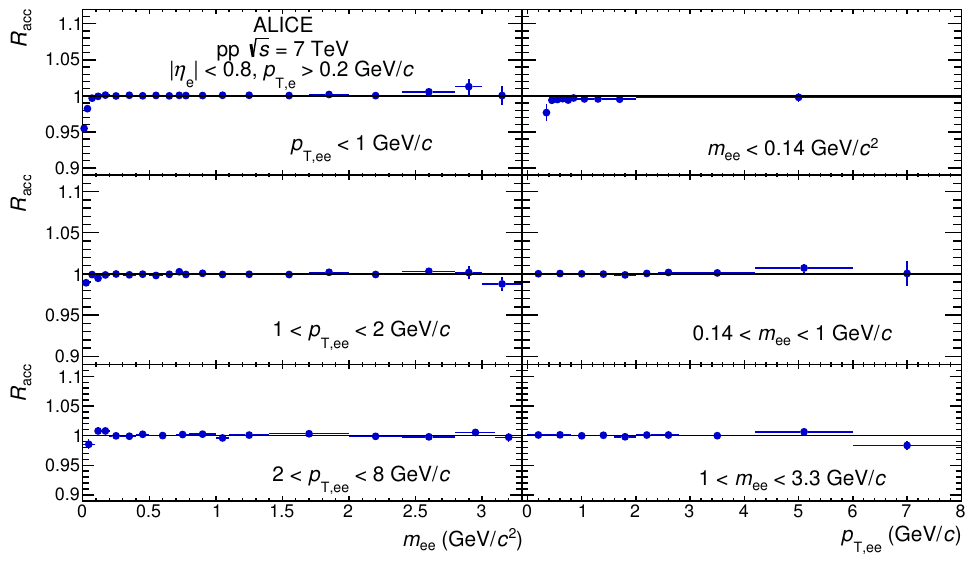
Figure 5 . Relative acceptance correction factor R acc as a function of m ee (left) and p T ; ee (right). Statistical uncertainties are represented by vertical